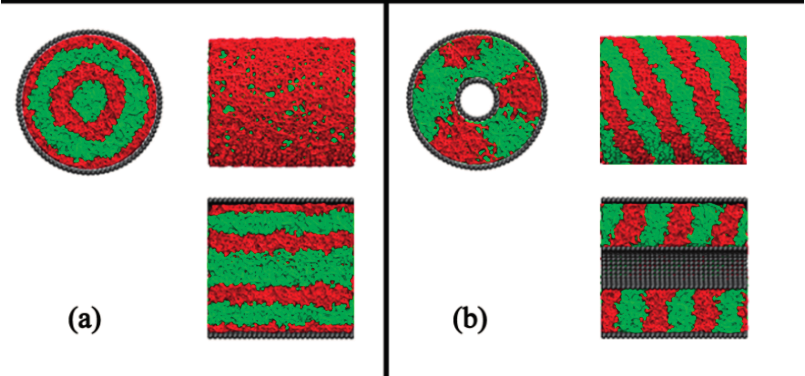
Figure 1. Morphologies of diblock copolymers within ( a ) a single nanotube and ( b ) multi-walled nanotubes. Top, side, and sectional views are shown. A blocks are shown in green, and B blocks in